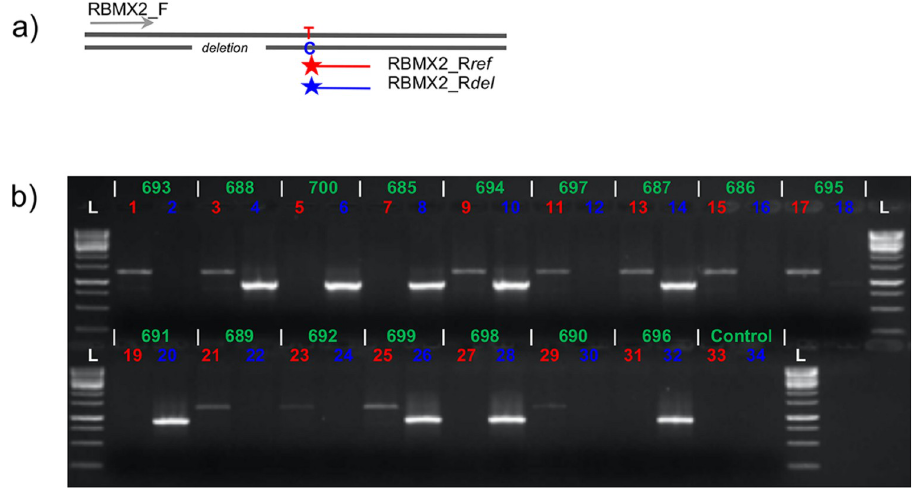
Fig 5. Verification of the RBMX2 330bp Alu deletion using PCR and Sanger Sequencing. ( a ) A schematic overview of the allele specific primer design. ( b ) An agarose gel image with two allele specific PCRs (a reference allele, 1215bp, and a 330bp deletion allele) were performed for each of the sixteen samples. Numbers colored with red are PCR reactions with RBMX2_F and RBMX2_Rref primers (a reference allele) and with blue RBMX2_F and RBMX2_Rdel (a deletion allele), respectively. L = 1kbp Ladder (ThermoFisher Scientific, CA, USA), 1–2 : female sample 693, 3–4 : female sample 688, 5–6 : male sample 700, 7–8 : male sample 685, 9–10 : female sample 694, 11–12 : male sample 697, 13–14 : female sample 687, 15–16 : male sample 686, 17–18 : female sample 695, 19–20: male sample 691, 21–22: male sample 689, 23–24: male sample 692, 25–26: female sample 699, 27–28: male sample 698, 29–30: male sample 690, 31– 32: male sample 696, 33–34: Negative PCR controls. On the top row the sample ID numbers are listed in green with the corresponding well numbers on the agarose gel image. Below, the reference allele is marked in red and the deletion allele in